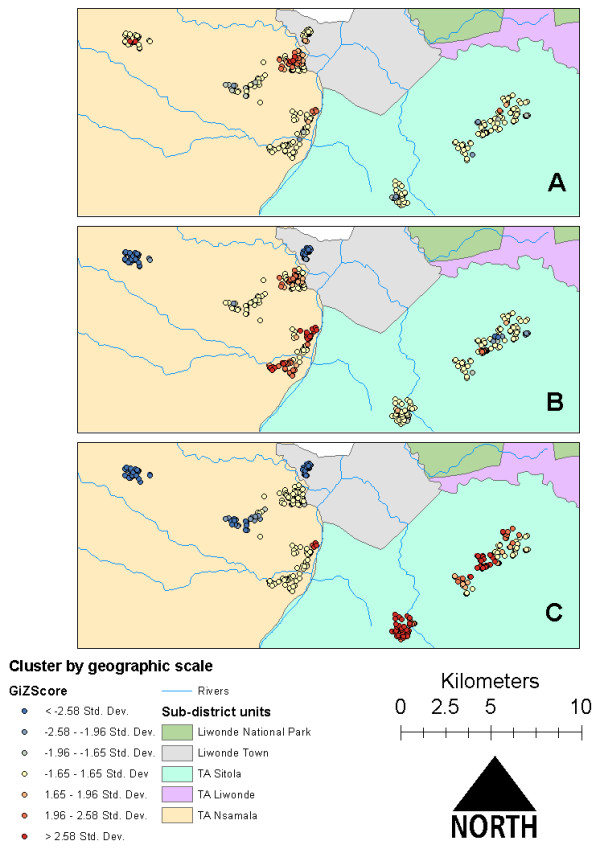

Plasmodium
infection case clusters assessed at the scales of A) village, B) Traditional Authority (TA), and, C) entire study area extent near Liwonde, Malawi during June to August 2011.